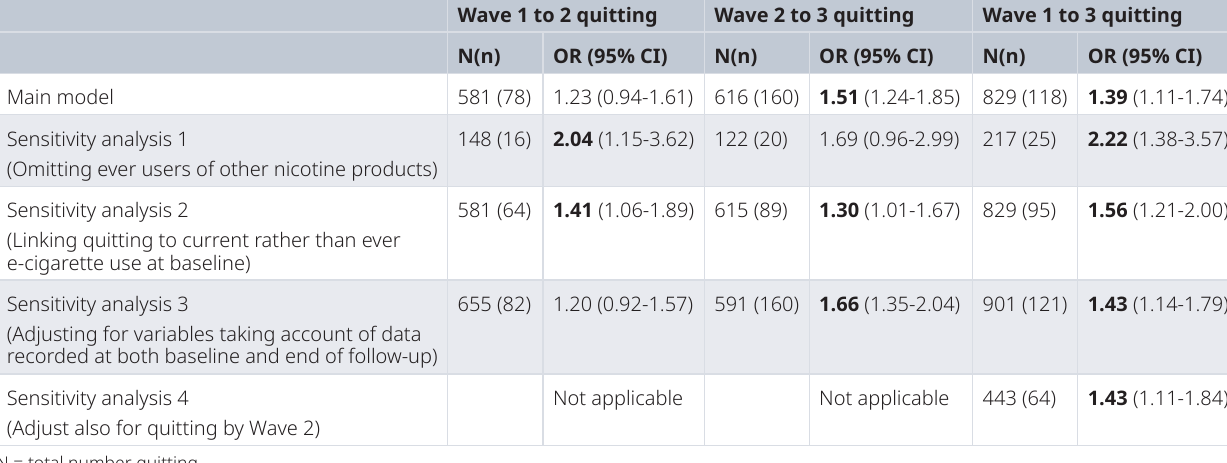
Table 4. Comparing adjusted ORs for the effect of e-cigarette use on quitting in the main and sensitivity analyses. Wave 1 to 2